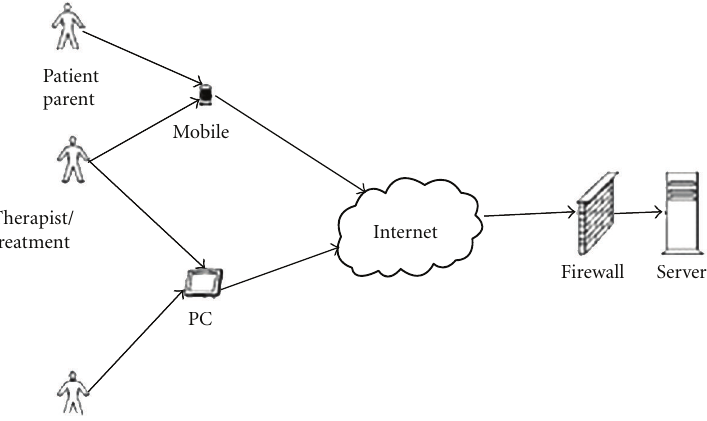
Figure 2: Schematic description of the new solution.